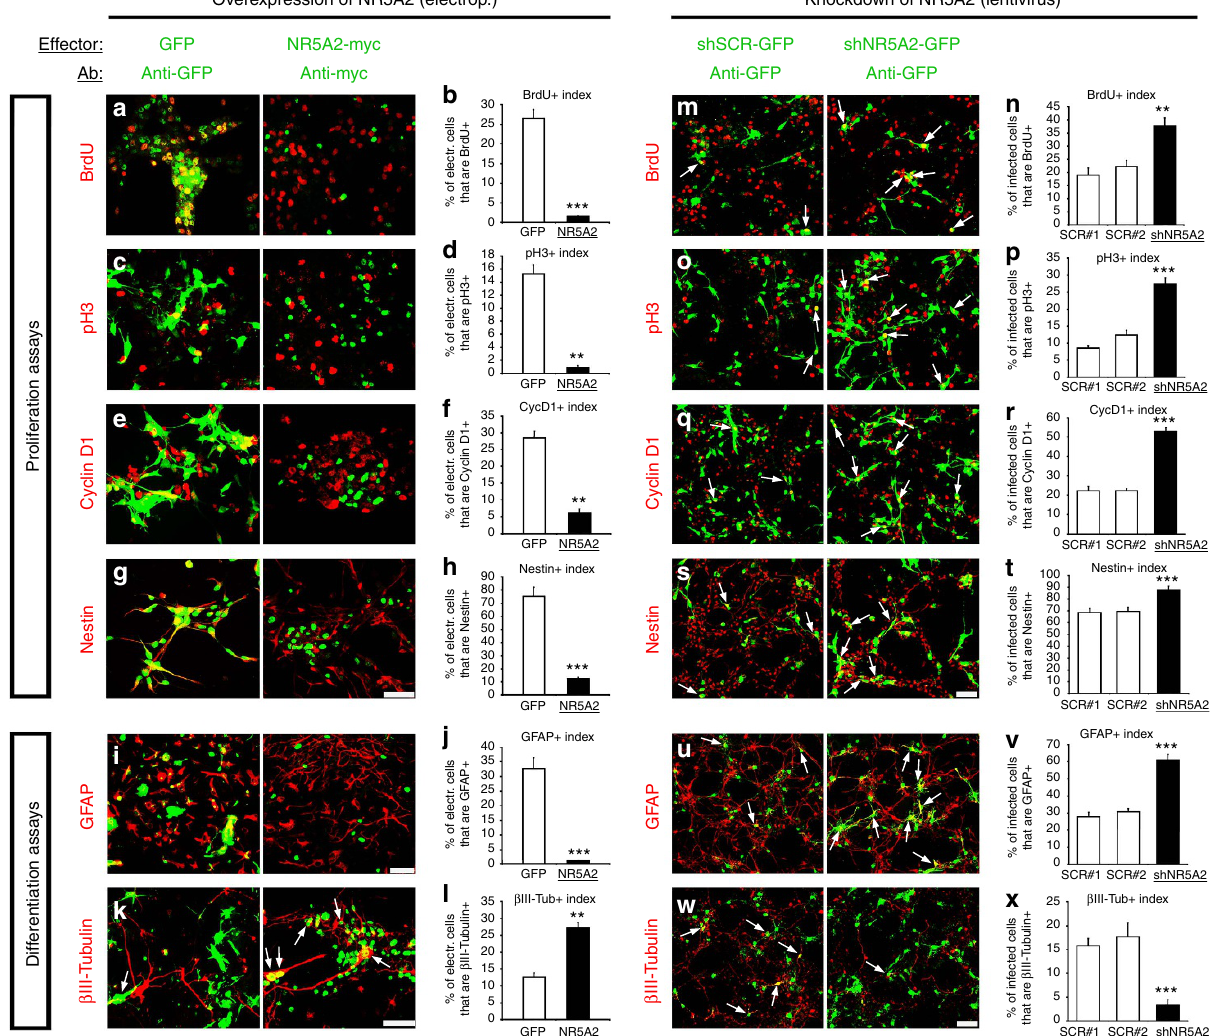
Figure 3 | NR5A2 regulates self-renewal and differentiation properties of NSCs. ( a – l ) Double immunostainings of Amaxa-electroporated NSCs with GFP or NR5A2-myc (green, detected with myc) and various markers (all red), as indicated ( a – k ). Quantifications of the indices of the above markers are shown in b , d , f , h , j and l , respectively (% of GFP þ or NR5A2-myc þ ; marker þ /total GFP þ or NR5A2-myc þ ). ( m – x ) Double immunostainings of GFP with the same markers, as indicated. Cells were infected with lentiviruses expressing control-scrambled sequences (shSCR#1-GFP, shSCR#2-GFP) or one potent shRNA targeting mouse NR5A2 (shNR5A2-GFP). All vectors co-express GFP from independent promoters. Quantifications of the indices are shown in n , p , r , t , v and x (% of GFP þ ; marker þ /total GFP þ ). In every case, arrows indicate representative GFP þ or NR5A2-myc þ cells that co-express each marker. The results are shown as mean ± s.d. ** P o 0.01, *** P o 0.001 (Student’s t -test). Scale bars, 50 m